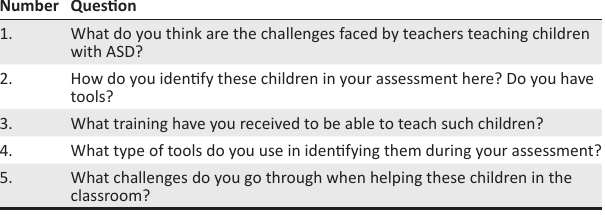
TABLE 1: Sample questions in the interview schedule.